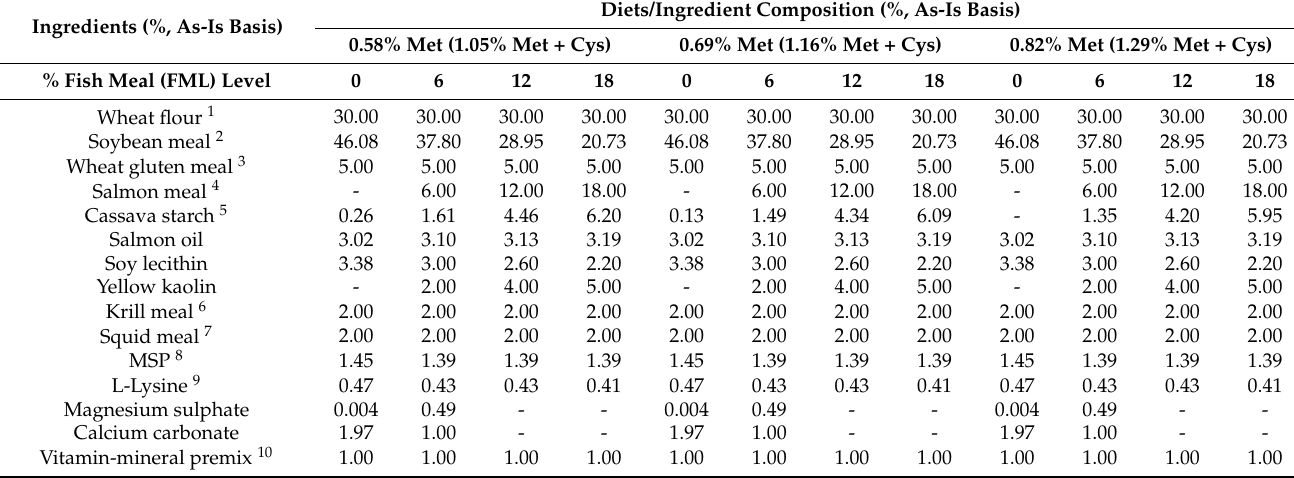
Table 1. Ingredient composition (%, as-is) and formula cost (USD/kg) of diets prepared to evaluate growth